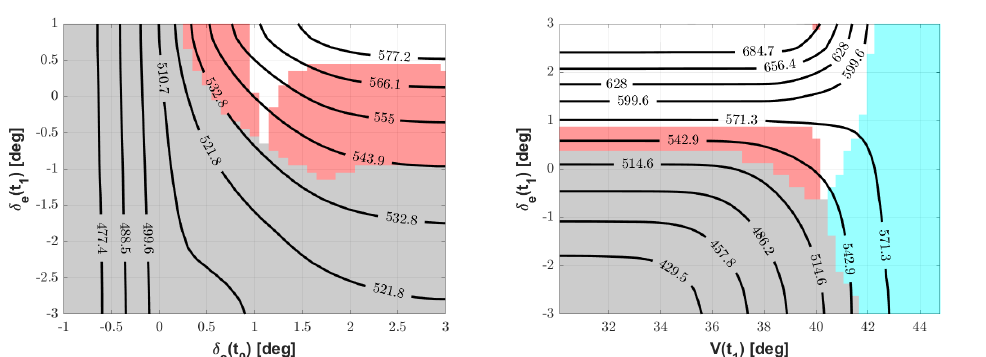
Figure 11. Take-off distance for the three-surface aircraft with optimal linkage, as a function of δ e ( t 0 ) and δ e ( t 1 ) for optimal V ( t 1 ) ( left ), and as a function of δ e ( t 1 ) and V ( t 1 ) for optimal δ e ( t 0 ) ( right ). Red area: tail strike. Cyan area: take-off before control pull-up. Grey area: two or more constraints